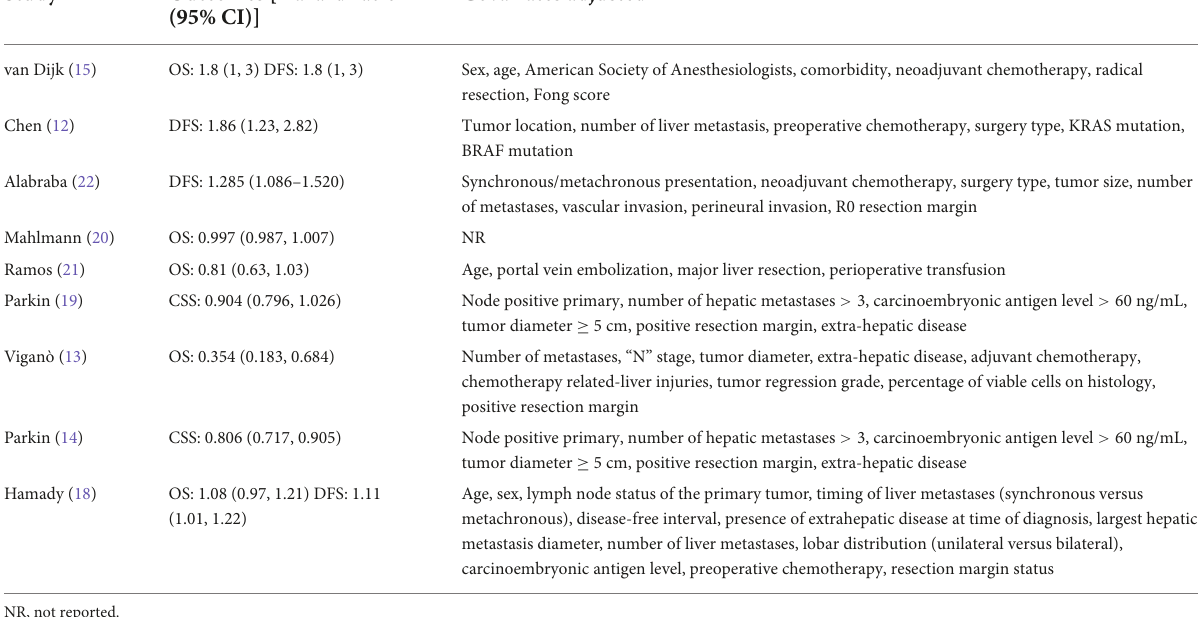
TABLE 2 Details of study results and covariates adjusted in the analysis.